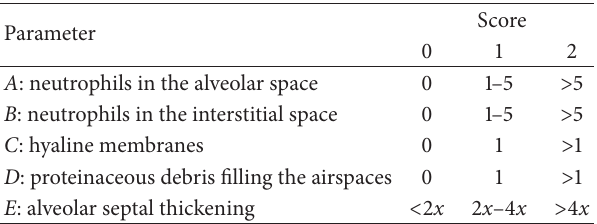
Table 1: Lung injury score